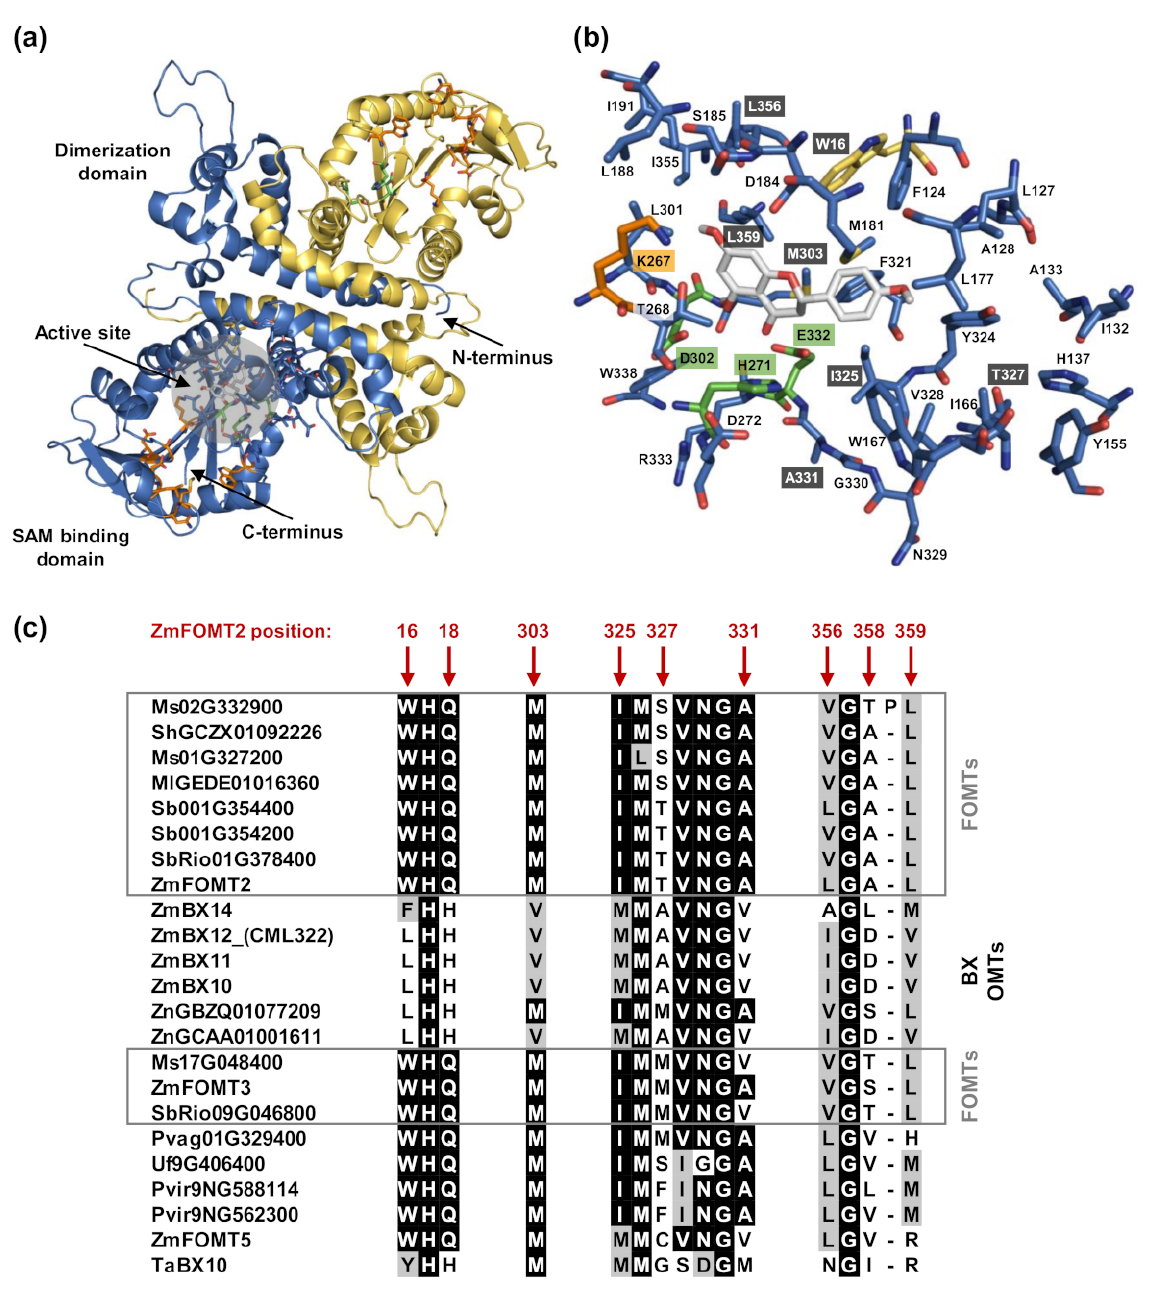
Figure 3. Structural model of ZmFOMT2 and alignment-based identification of putative active site residues. ( a ) Homology model of the biological homodimer of ZmFOMT2 (chain A: blue; chain B: gold) based on the template isoflavone 4 (cid:48) -OMT from Medicago truncatula (MtHI4OMT; PDB-ID: 1ZG3). Labels correspond to the monomer colored in blue. A close-up view of the putative active site is shown in ( b ), representing the 6 Å area around naringenin, docked in as a model flavonoid substrate. Amino acid residues (carbon atoms) are color-coded, with the catalytic triad in green, SAM binding residues in orange, naringenin in gray, and all other protein carbon atoms in blue (chain A) and gold (chain B). Oxygen atoms are red, nitrogen atoms are blue, and sulfur atoms are yellow. Mutation sites are labeled in dark gray. ( c ) Alignment of putative active site residues that differ between all ZmFOMT2-like FOMTs (gray boxes) and BX OMTs, respectively. The amino acid sequence sections are cut from the complete alignment given in Figure S5. Identical amino acids are shaded in black, and similar amino acids are in